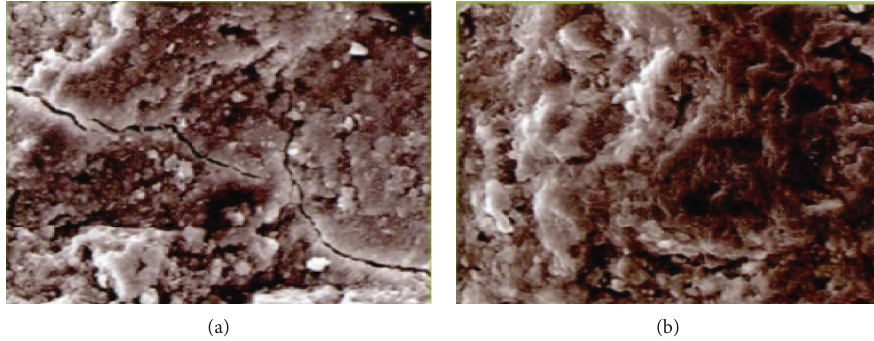
Figure 4: Contrast of microstructure between (a) traditional mixing and (b) vibratory mixing.